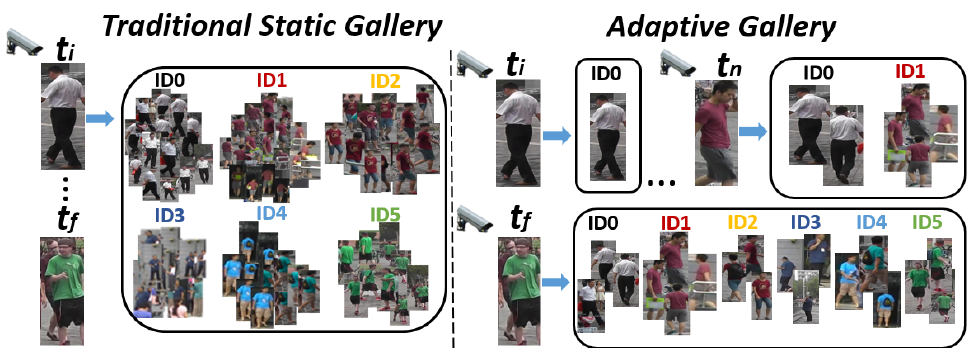
Figure 1. Simplified comparison between a large static gallery, traditionally used, and our small self-adaptive gallery. Both have a set of images representing each identity (ID0, ID1, ...), i.e., each person. The traditional gallery is the same for every person query that arrives at different times ( t i , t f ). However, because the adaptive gallery is being built and updated as new data arrives, we can appreciate a more comprehensive gallery for later times ( t i < t n < t f